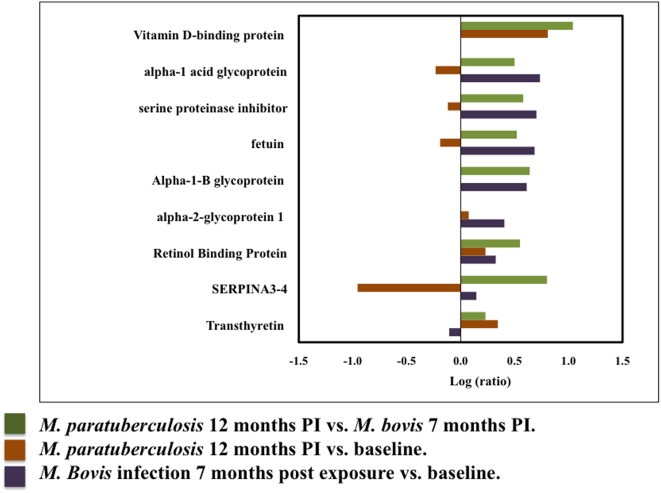
Biomarkers identified in M. bovis and M. paratuberculosis infection.The bar graph represents log ratios of serum proteins identified (P-value<0.05, EF<2) in M. bovis infected and M. paratuberculosis infected animals. The purple bars represent the log ratios of proteins following infection with M. paratuberculosis at 7 months PI vs. pre-infection. The brown bars represent log rations of proteins following infection with M. bovis at seventh month PI vs. pre-infection. The green bars represent log ratio of proteins at 12 months PI vs. M. bovis 7 months PI. Serum levels of D-binding protein and transthyretin were significantly increased in M. paratuberculosis infected animals compared with controls, while the serum levels of AMBP protein, alpha-1 acid glycoprotein, fetuin, and alpha-1B glycoprotein were elevated exclusively in M. bovis infected animals.